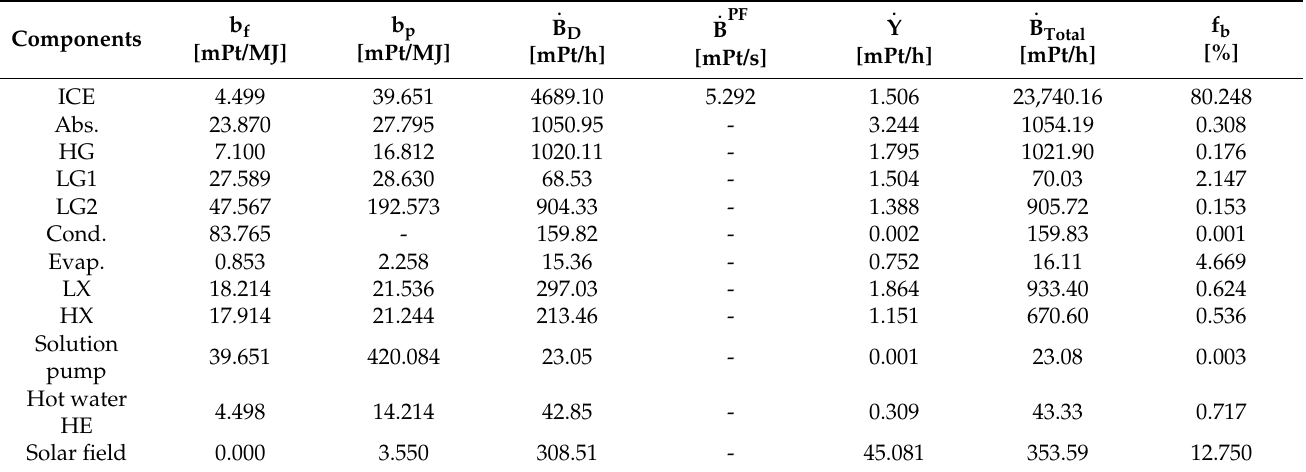
Table 6. Exergoenvironmental variables.